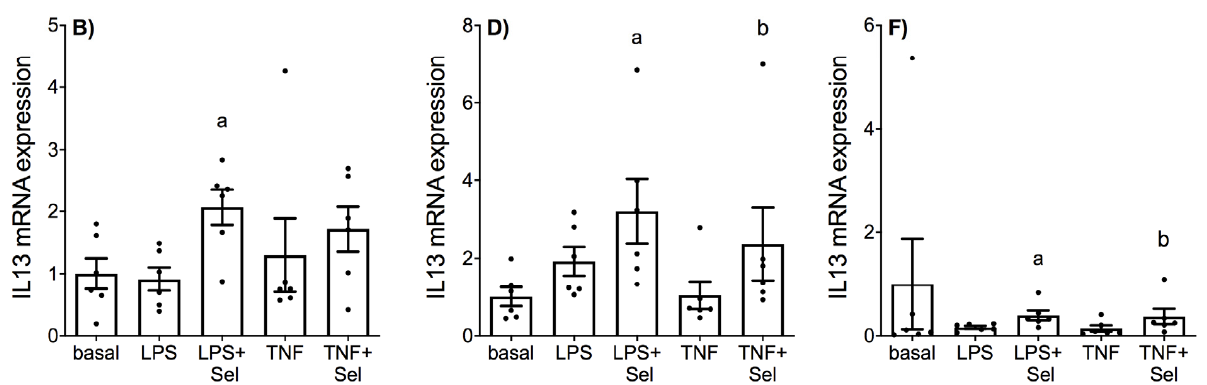
Figure 3. Effect of selenium on anti-inflammatory cytokine expression in human placenta, and VAT and SAT from pregnant women. ( A , B ) Placenta ( n = 6 patients), ( C , D ) VAT ( n = 6 patients) and ( E , F ) SAT ( n = 6 patients) were incubated with or without 10 µM sodium selenite (Sel) for 1 h and then stimulated with 10 µg/mL LPS or 10 ng/mL TNF- α for a further 20 h. IL4 and IL13 mRNA expression was analysed by RT-qPCR and fold change was calculated relative to basal expression. For all graphs, individual data points represent 6 independent experiments and are displayed as mean ± SEM. a p ≤ 0.05 vs. LPS, b p ≤ 0.05 vs. TNF; repeated measures one-way ANOVA.